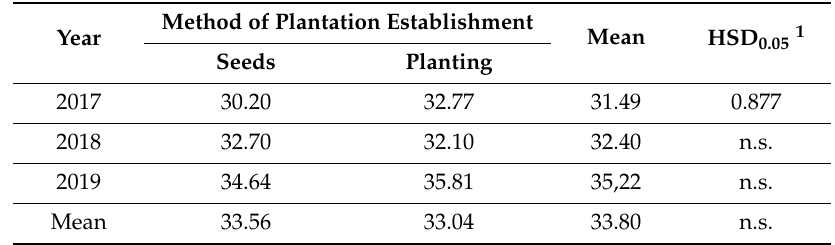
Table 9. The Leaf Greenness Index (LGI) of Silphium plants (SPAD), depending on methods of plantation